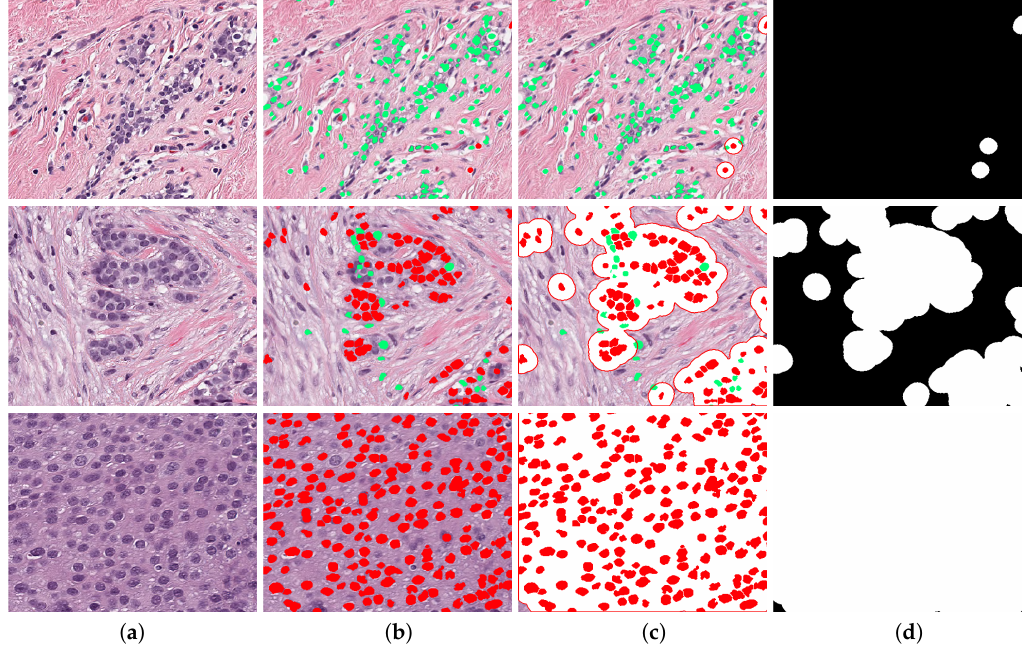
Figure 9. Visual description of the method. Three TC cases are presented in each row: 0, 0.5 and 1. ( a ) The original image, the image is segmented and key parameters are computed, then a classification predictor estimates either malignant or benign cells, shown in red and green, respectively in ( b ). A dilation of segmented malignant nuclei estimates full cytoplasm of every detected malignant cell ( c ) and TB region is shown in white in ( d ). The cellularity metrics calculated by the proposed methodology are: TC = 0.0113, TC = 0.5181 and TC =